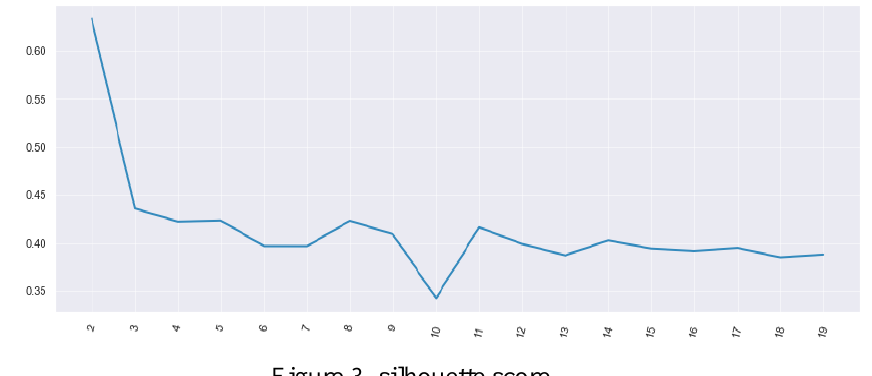
Figure 3. silhouette score